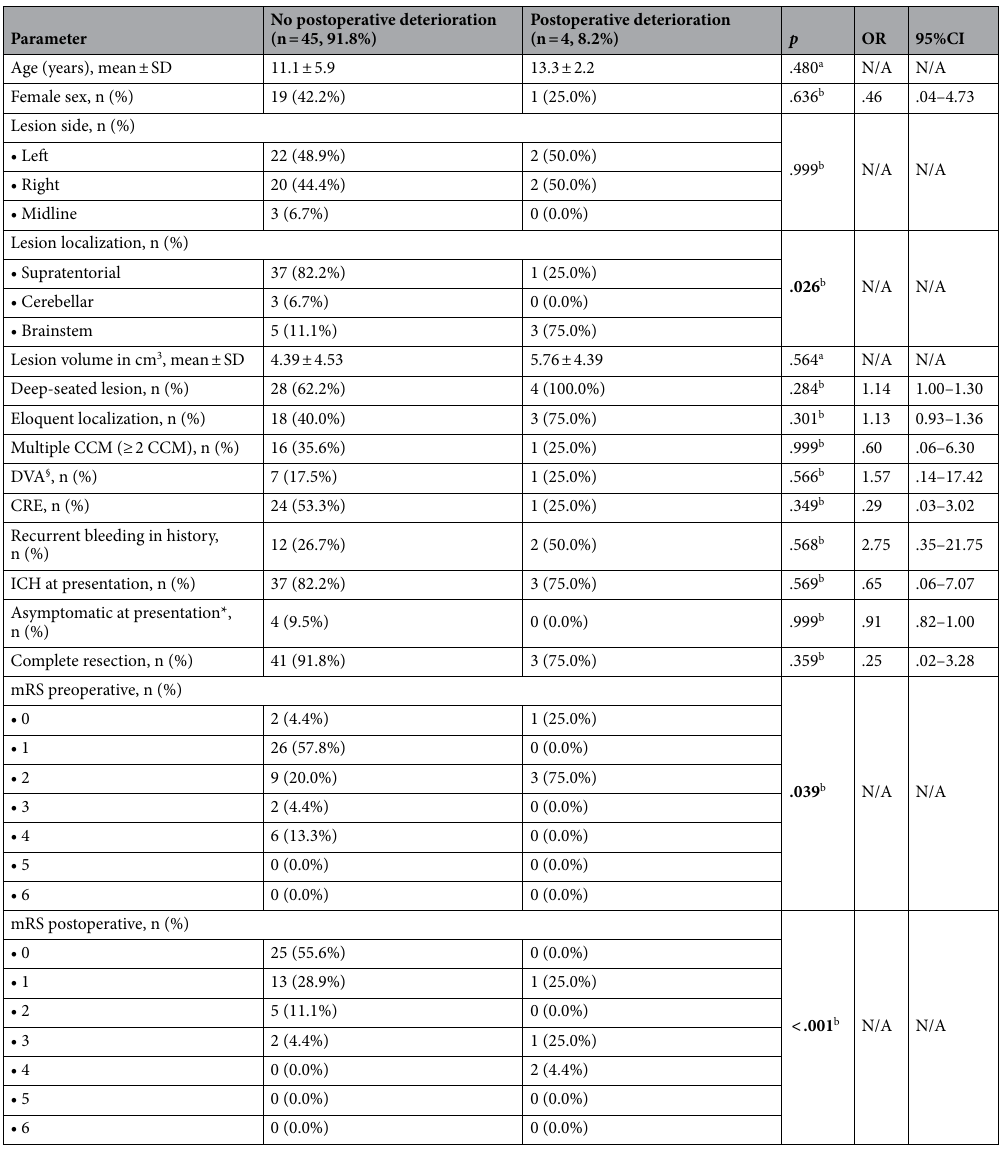
Table 1. Univariate analysis of demographic, clinical and anatomical predictors for postoperative deterioration. A minimum one-point increase on the mRS score compared to the preoperative score was defined as deterioration. Changes in mRS refer to comparison between mRS at admission and final follow-up. P values marked with bold indicate statistically significant differences between the groups. a Student’s